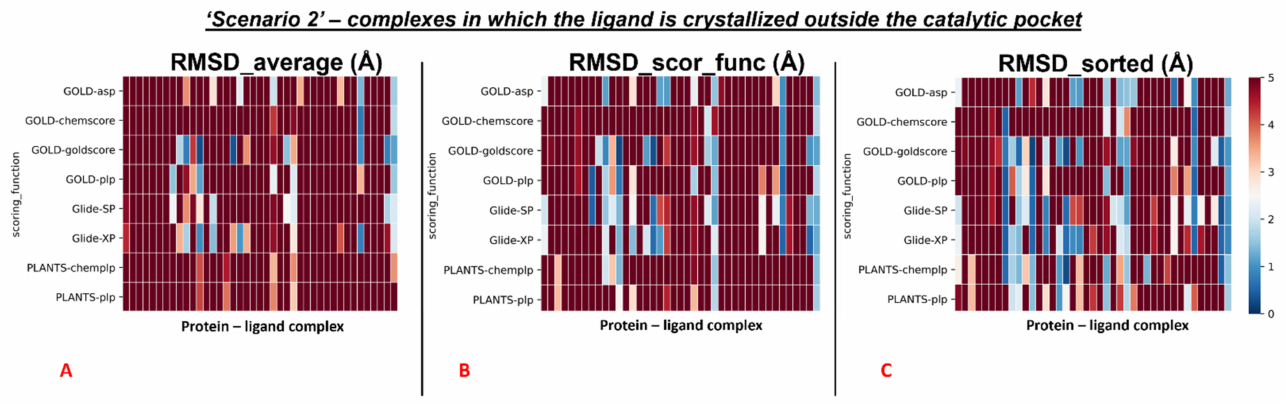
Figure 8. Colormaps represent the results of the self-docking experiments only for the ligands crystallized outside the orthosteric pocket in the situation in which the crystallographic water molecules at 5 Å or nearer to the ligand itself are taken into account during the docking runs. ( A ) Results coming from the average of the RMSDs of all the poses for each docking run. ( B ) Results derived just from the RMSD between the crystallographic ligand coordinates and the once of the pose classified as the best from the scoring function. ( C ) Results of the self-docking experiments if just the pose showing the best RMSD value between its coordinates and the crystallographic ones are retained. The x -axis lists all the different protein–ligand complexes, which are plotted against the different pairs docking program-scoring function used for this study, reported in the y